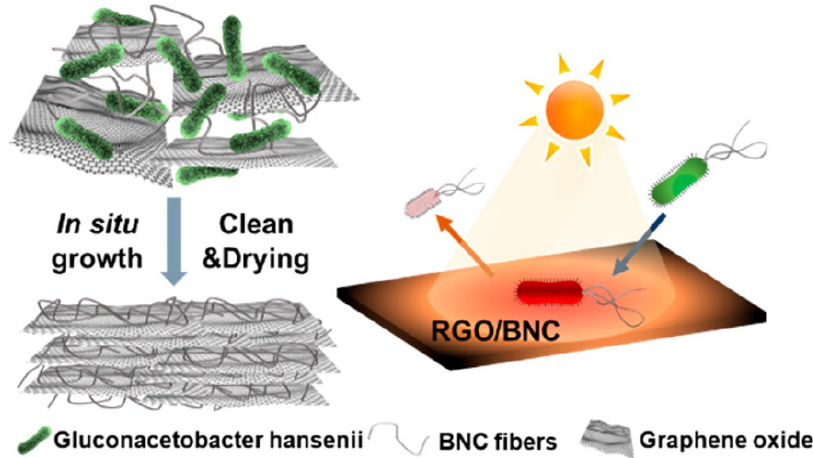
Figure 18. Schematic representation of UF membrane synthesis by using BNC fibers. Re- Figure 13. Schematic representation of UF membrane synthesis by using BNC fibers. Reprinted with printed/adapted with permission from [155]. permission from Ref. [155]. Copyright 2019 American Chemical